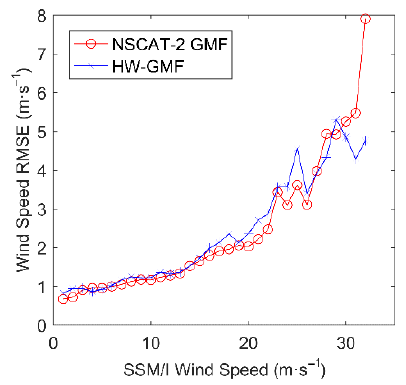
Figure 10. RMSE of the HY ‐ 2A retrieved wind vectors against the SSM/I wind speed. The red circle in this figure is the RMSE of the NSCAT ‐ 2 GMF retrieved wind speed, and the blue asterisk is the RMSE of the HW ‐ GMF retrieved wind speed.